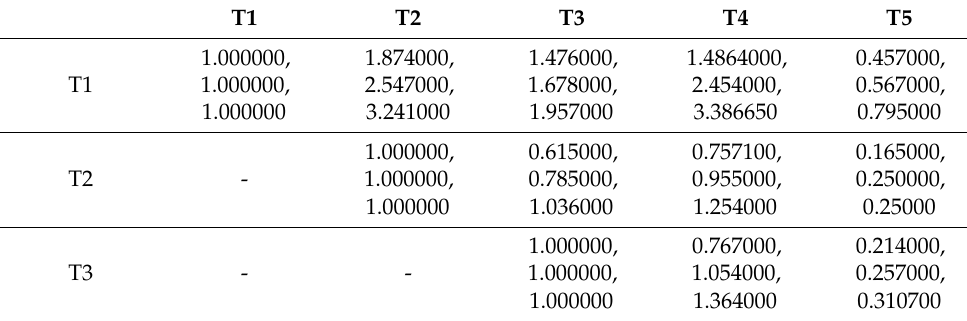
Table 1. Fuzzy pair-wise comparison matrix at level